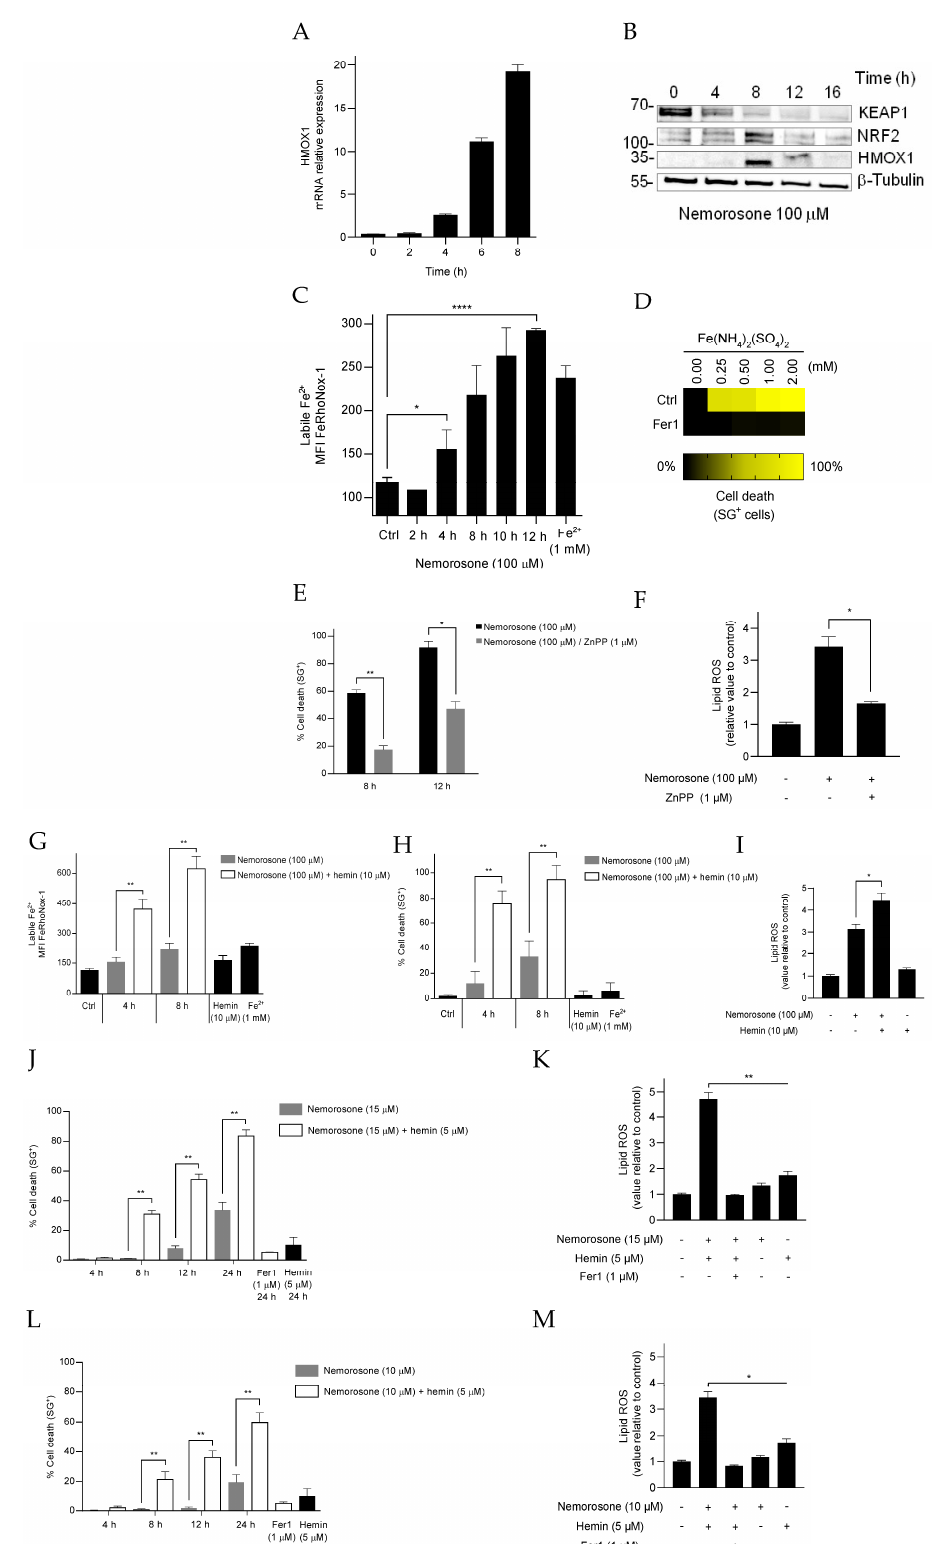
Figure 5. Nemorosone-induced ferroptosis in HT1080 cells involves excessive activation of HMOX1. ( A ) Relative HMOX1 expression at mRNA level in HT1080 cells following nemorosone treatment (100 μ M) at different time points. ( B ) Western blot showing KEAP1, NRF2, and HMOX1 modulation in HT1080 cells after treatment with nemorosone (100 μ M). ( C ) Cellular levels of labile Fe 2+ , deter- mined by flow cytometry using FeRhoNox-1 dye, at different time points, after nemorosone treat- ment (100 μ M). Measurements were performed in live HT1080 cells (SytoxBlue-negative cells). Fer- rous ammonium sulfate [Fe(NH 4 ) 2 (SO 4 ) 2 ] was used as a control (2 h, 1 mM). MFI is the median flu- orescence intensity of the fluorophore. ( D ) Heatmap showing the sensitivity to cell death of HT1080 cells treated with different concentrations of Fe(NH 4 ) 2 (SO 4 ) 2 in the presence or absence of Fer1 (1 μ M), assessed using SytoxGreen dye. ( E ) Percentage of cell death induced by nemorosone (100 μ M) in the presence or absence of ZnPP (1 μ M), assessed using SytoxGreen dye. ( F ) Analysis using flow cytometry of the C11-BODIPY lipid peroxidation sensor in live HT1080 cells (DRAQ7-negative cells) after 8 h of treatment with nemorosone (100 μ M) in the presence or absence of ZnPP (1 μ M). ( G ) Cellular levels of labile Fe 2+ , determined by flow cytometry using FeRhoNox-1 dye, in response to nemorosone (100 μ M), in the presence or absence of hemin (10 μ M). Measurements were performed in live HT1080 cells (SytoxBlue-negative cells). Ferrous ammonium sulfate was used as a control (2 h, 1 mM). MFI is the median fluorescence intensity of the fluorophore. ( H ) Percentage of cell death induced by nemorosone (100 μ M) in the presence or absence of hemin (10 μ M) in HT1080 cells, assessed using SytoxBlue dye. ( I ) Analysis using flow cytometry of the C11-BODIPY lipid peroxi- dation sensor in live HT1080 cells (DRAQ7-negative cells), following 8 h of treatment with nem- orosone (100 μ M), in the presence or absence of hemin (10 μ M). ( J , L ) Percentage of cell death at different time points induced by nemorosone 15 and 10 μ M, respectively, alone and in combination with hemin (5 μ M). Cell death was assessed using SytoxGreen dye. ( K , M ) Analysis using flow cy- tometry of the C11-BODIPY lipid peroxidation sensor in live HT1080 cells (DRAQ7-negative cells) after treatment with nemorosone 15 and 10 μ M, respectively, alone and in combination with hemin (5 μ M) for 4 h. The combined results of 2 or 3 separate experiments are presented for ( C – M ). All quantitative data are shown as mean ± SD. * p < 0.05, ** p < 0.01, and **** p < 0.0001 determined by unpaired Student’s t -test. 4. Discussion In the current work, nemorosone, a phytochemical isolated from the floral resin of the C. rosea plant, was identified to induce ferroptosis in fibrosarcoma and neuroblastoma